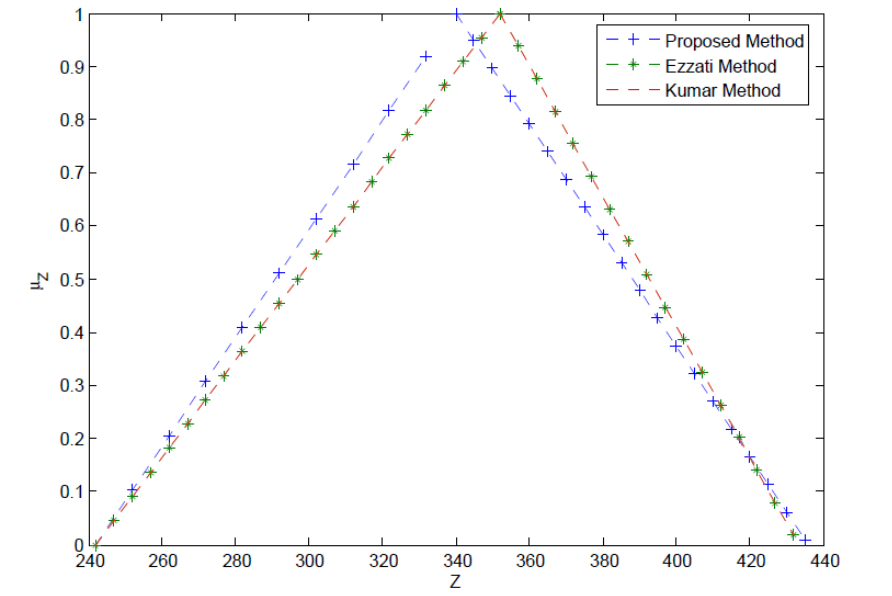
Figure 3 . Membership function: Proposed method vs existing